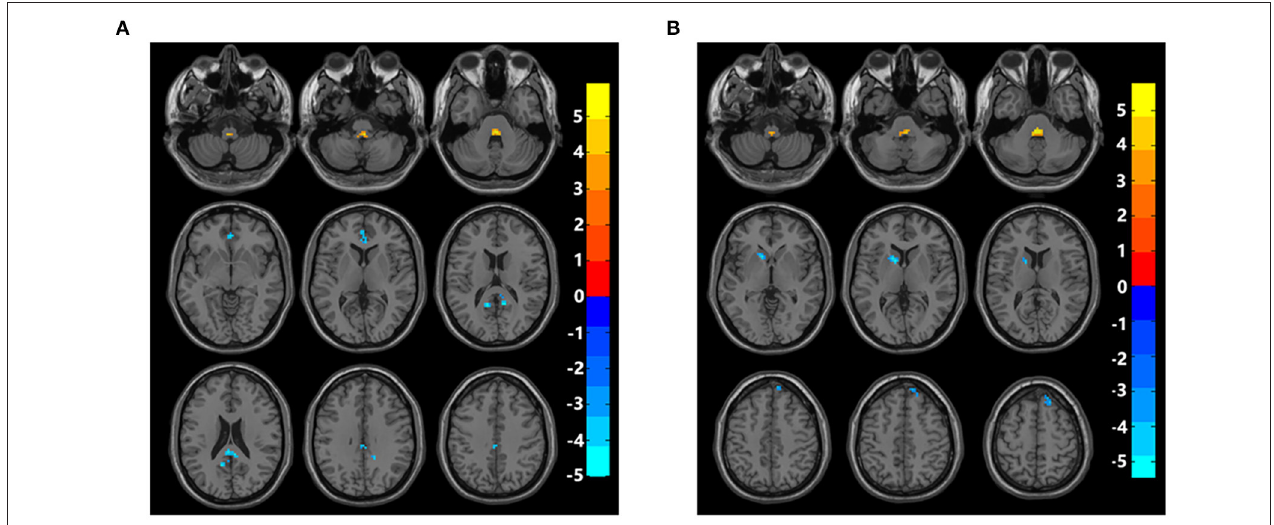
FIGURE 1 | Brain maps of fALFF differences. (A) Differences of fALFF between cognitive impairment group after hemorrhagic stroke and healthy control group. (B) Differences of fALFF between cognitive impairment group after ischemic stroke and healthy control group. fALFF, fractional amplitude of low-frequency fluctuations;